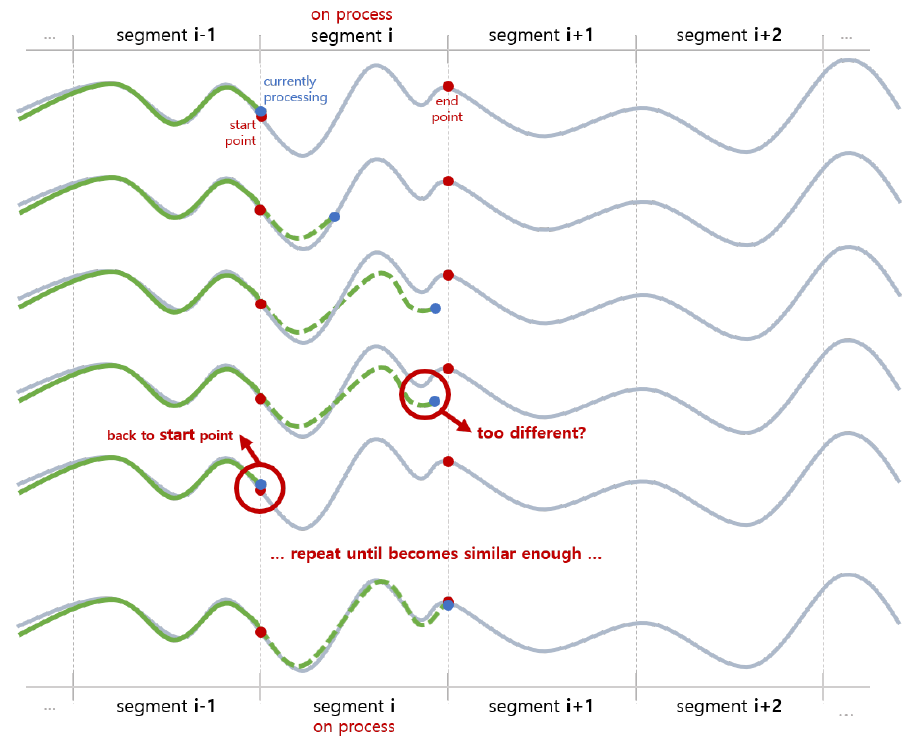
Figure 7. Trajectory optimization process based on similarity of curve shapes between input and simulated segments.